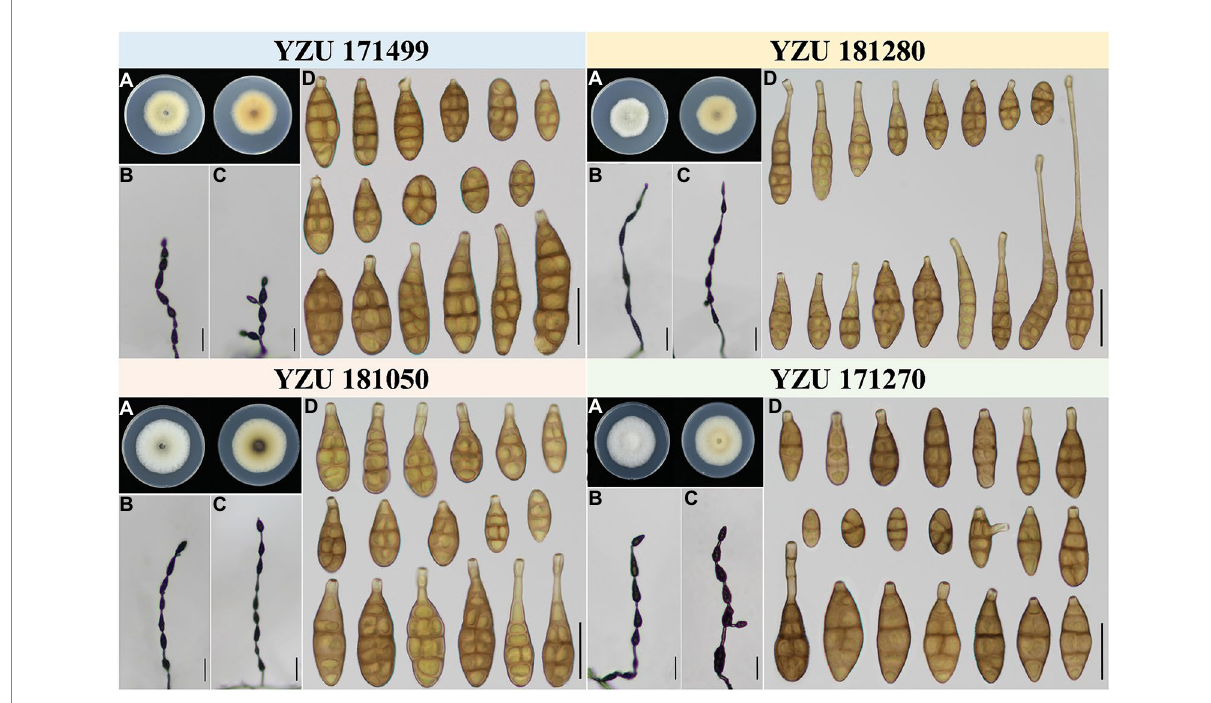
FIGURE 3 Morphology of the represent four strains of A. alternata. (A) Colony phenotype (on PDA for 7 days at 25 ° C); (B,C) Sporulation patterns (on PCA at 22 ° C); (D) Conidia Bars: B,C = 50 μ m; D = 25 μ